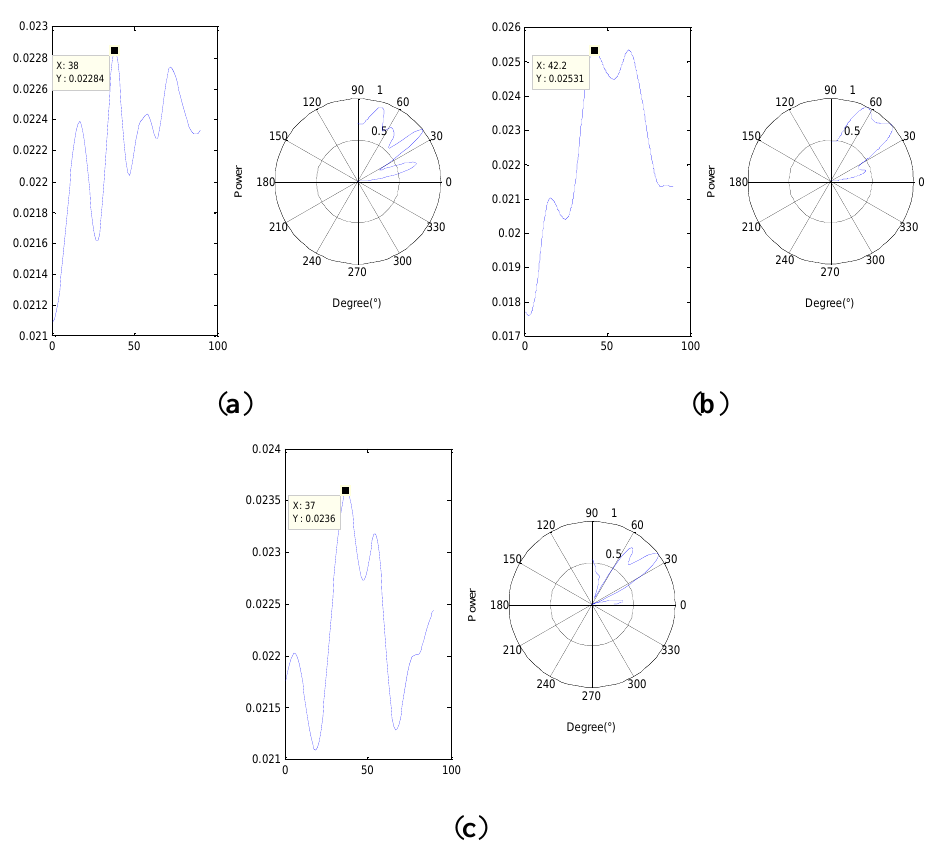
Figure 15. The orientation results ( a ) under T 1 and using H(f) ; ( b ) under T 1 and not using H(f) ; and ( c ) under T 2 and using H(f)